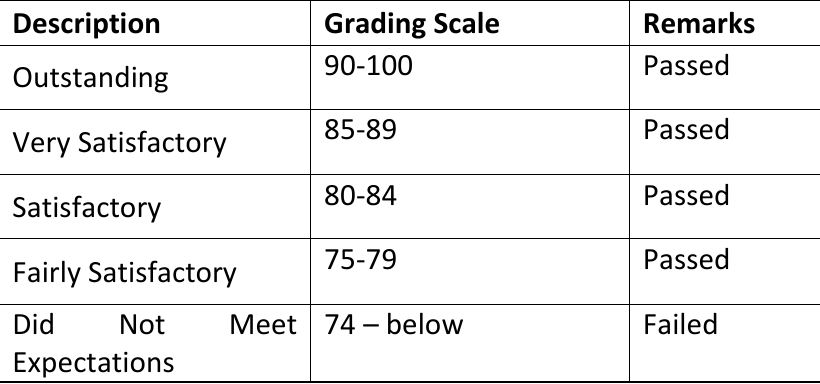
Table 1 : Description, Grading Scale and Remarks of the Grades